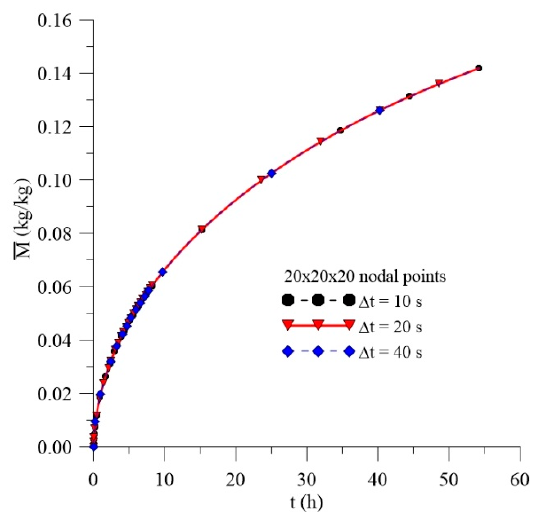
Figure 9. Transient behavior of the average moisture content for different time steps.